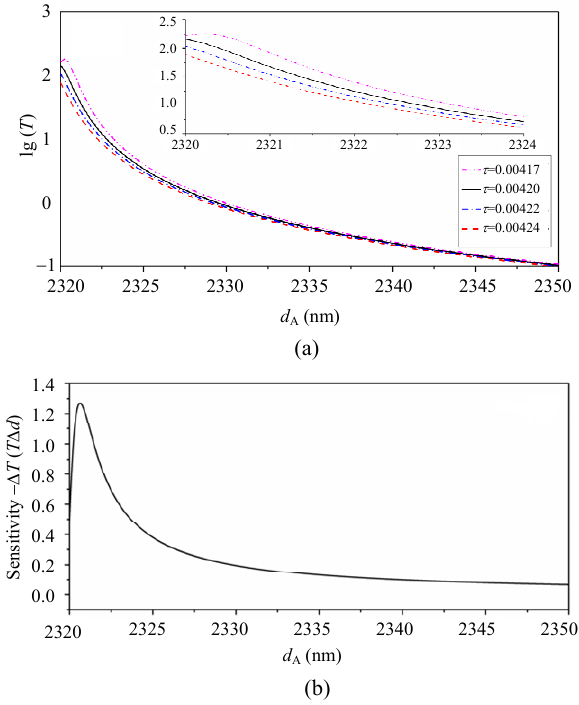
Fig. 5 Transmittance and sensitivity: (a) transmittance for different  and (b) the sensitivity for 